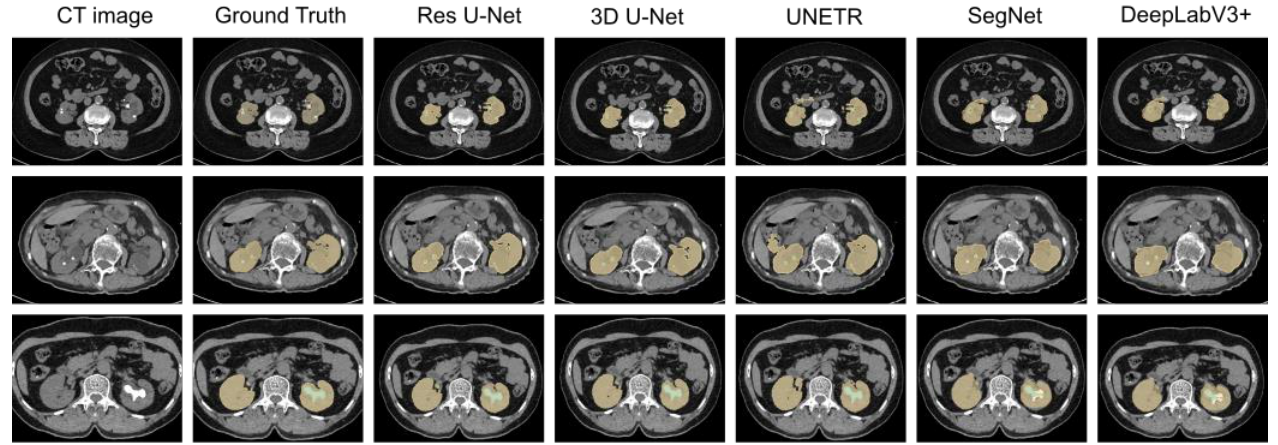
trained independently. independently.